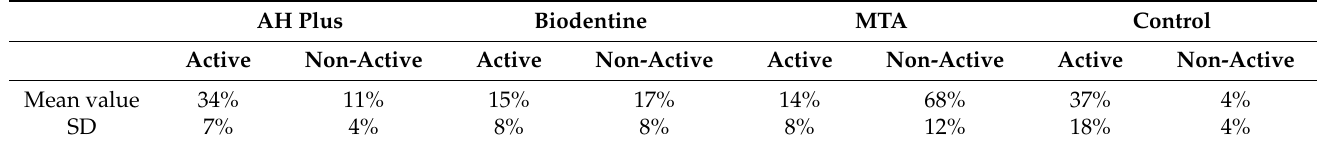
Table 3. The proportions of active and non-active microorganisms in relation to the surface area of the material and control samples after live/dead staining and fluorescence microscopy.